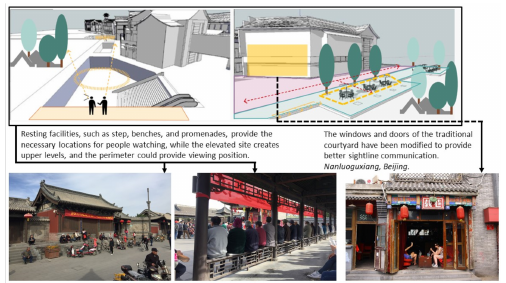
Figure 12. Creating shared spaces for all user groups contributes to the quality of the immersive experience. Source: